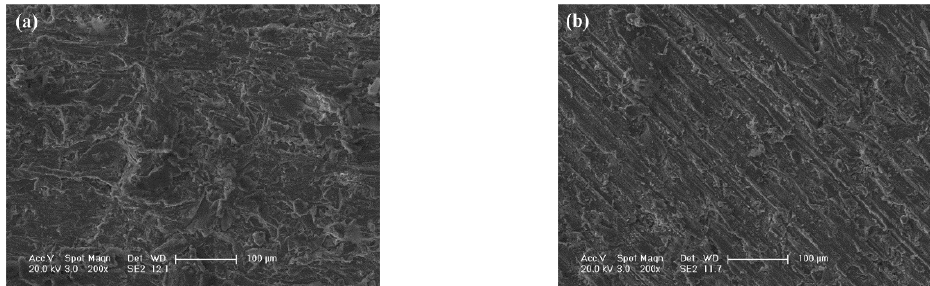
Figure 12. SEM pictures of worn surfaces of ( a ) N 2 flow rate of 1 L/min and ( b ) N 2 flow rate of 5 L/min.